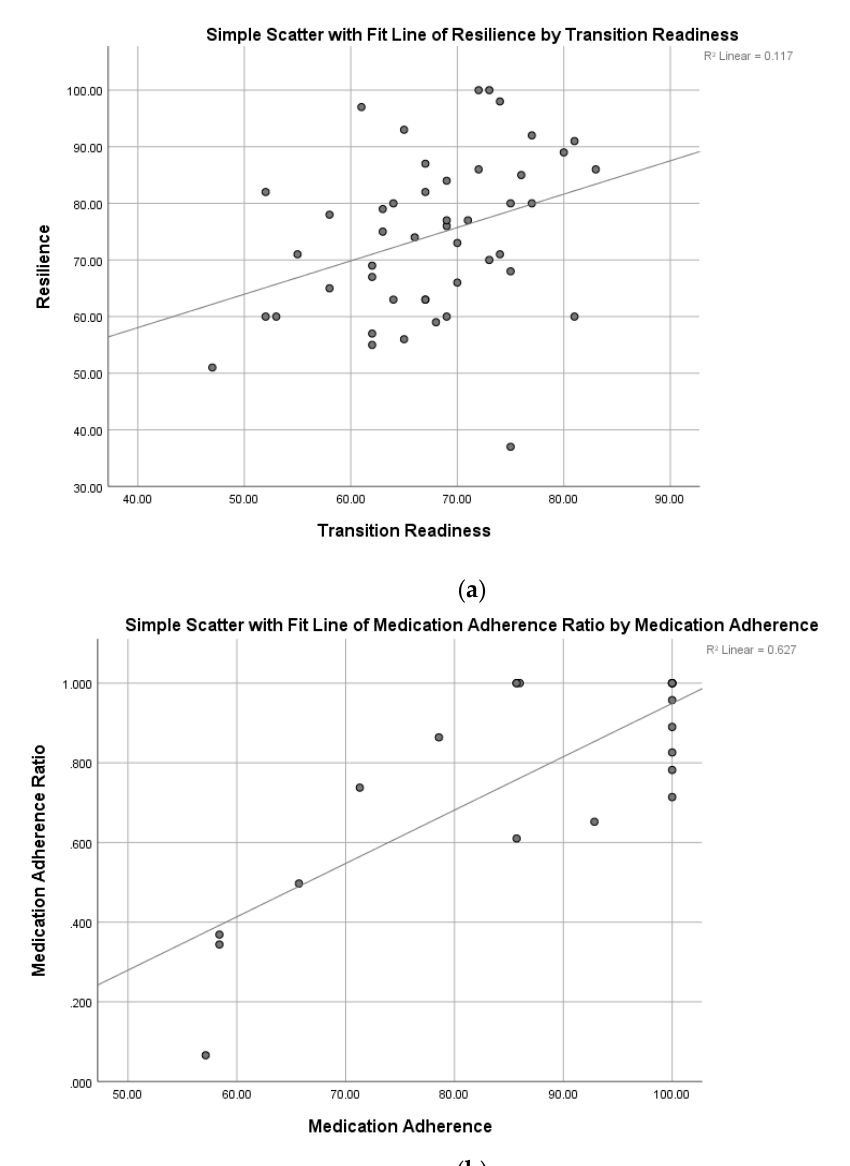
Figure 1. ( a ) Relationship between resilience and transition readiness. ( b ). Relationship between multiple measures of medication adherence.